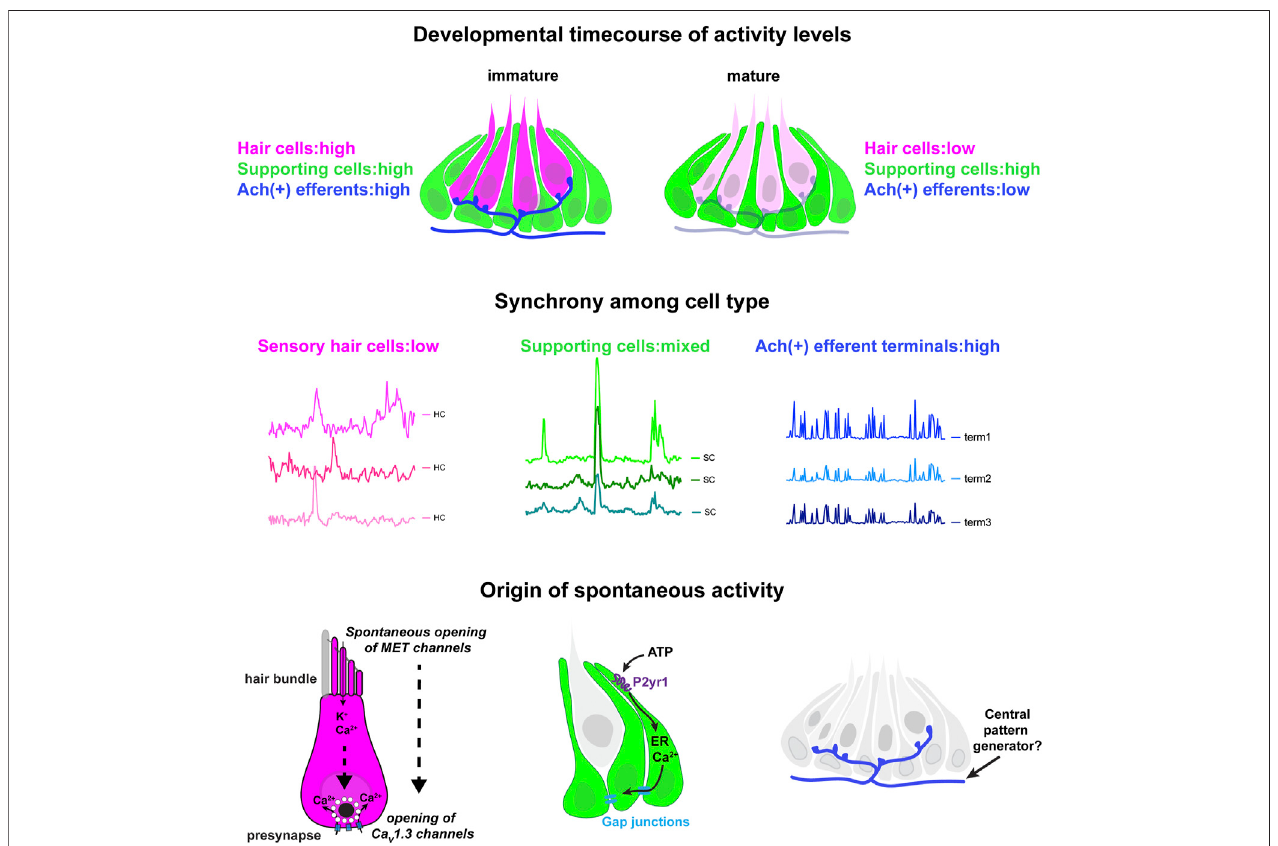
FIGURE 7 | Locations, mechanisms and developmental timecourse of spontaneous calcium activities in the lateral-line system. Top panel: we reliably detected spontaneous calcium activity in three cell types within the lateral-line system: hair cells, supporting cells and cholinergic (Ach (+)) efferent neurons. Spontaneous calcium activity in the supporting cells and cholinergic efferents is not correlated with calcium signals in hair cells. During development spontaneous calcium signals are robust in allthreecelltypes(leftside).Uponmaturation,spontaneouscalciumsignalsaredecreasedinhaircellsandefferentneurons,butmaintainedinsupportingcells(right side). Middle panel: Within a neuromast spontaneous calcium signals among populations of hair cells are not correlated (left side); supporting cells are moderately correlated(middle);cholinergicterminalsarehighlycorrelated(rightside).Bottompanel:Indeveloping haircells,spontaneousopeningofMETchannelsleadstocalcium signalsinmechanosensoryhairbundles.ThisapicalactivitytriggersopeningofCa V 1.3channelsatthepresynapse,resultinginspontaneouspresynapticcalciumsignals